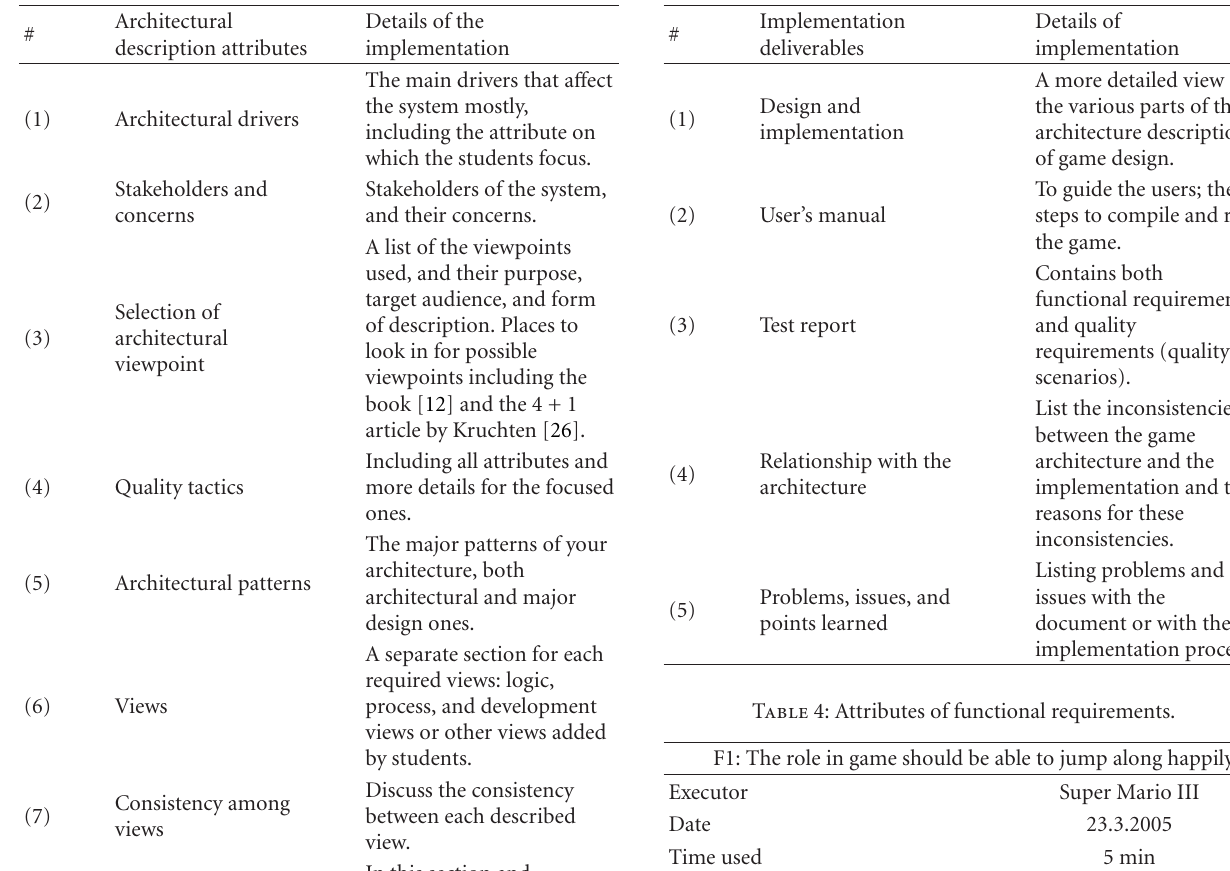
Table 2: List of architecture description for the game project. Table 3: Design & implementation phase description.